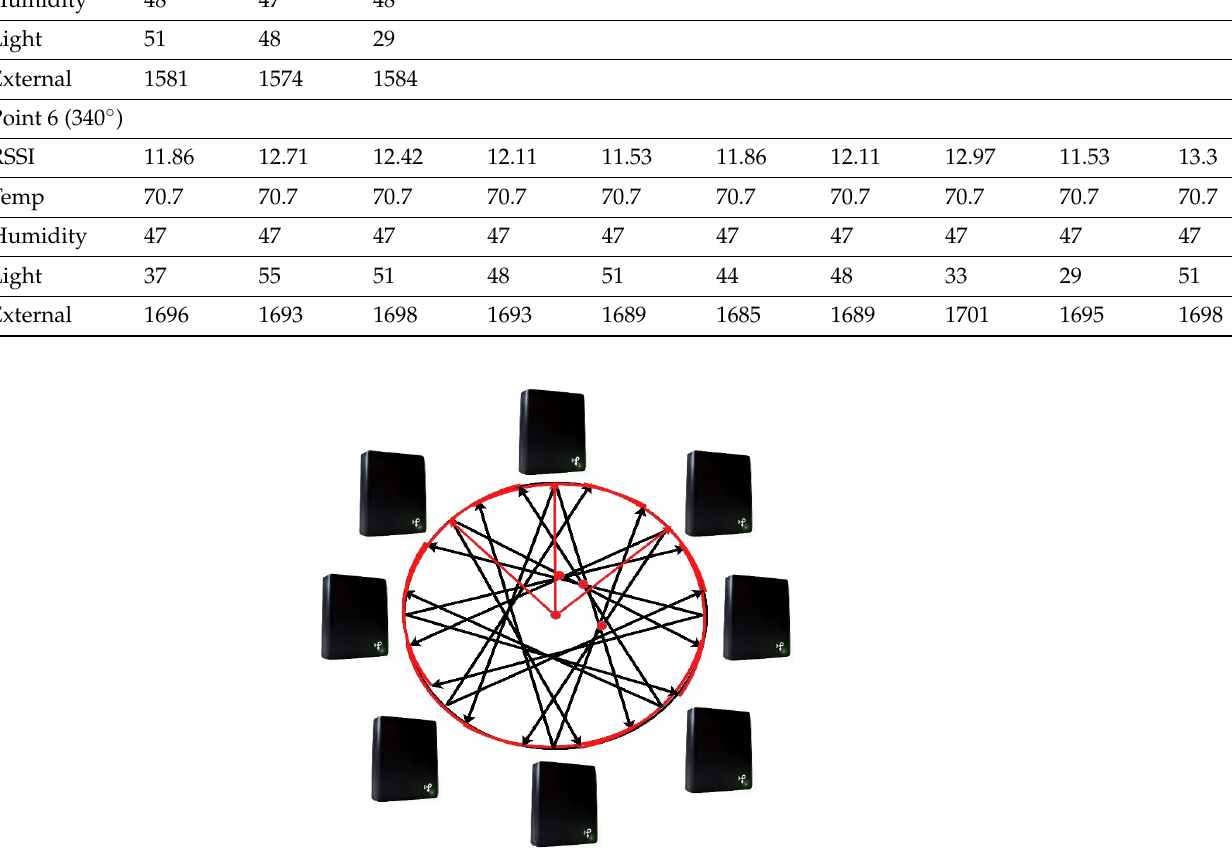
Figure 5. Sensor Device Placement for Patch Antenna. Table 2. Patch Antenna Sensed